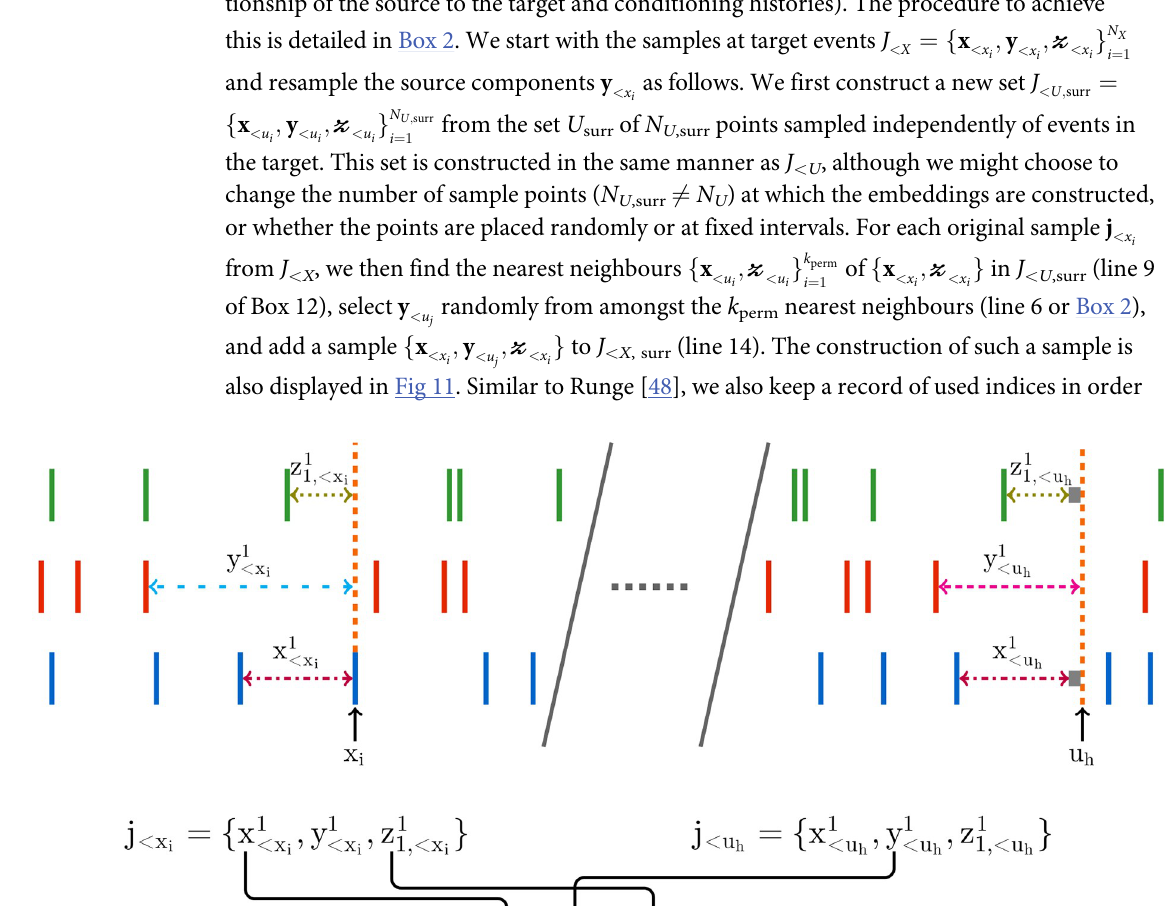
Fig 11. Diagrammatic representation of the local permutation surrogate generation scheme. For our chosen sample j where we have that the x . We then form a single surrogate sample by combining the x j < u h colours of the dotted interval lines indicates corresponding length. The grey boxes indicate a small delta.